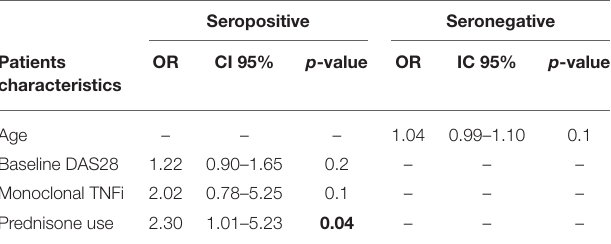
TABLE 4 | Association between patient characteristics and TNFi discontinuation (multivariable analysis), stratified by